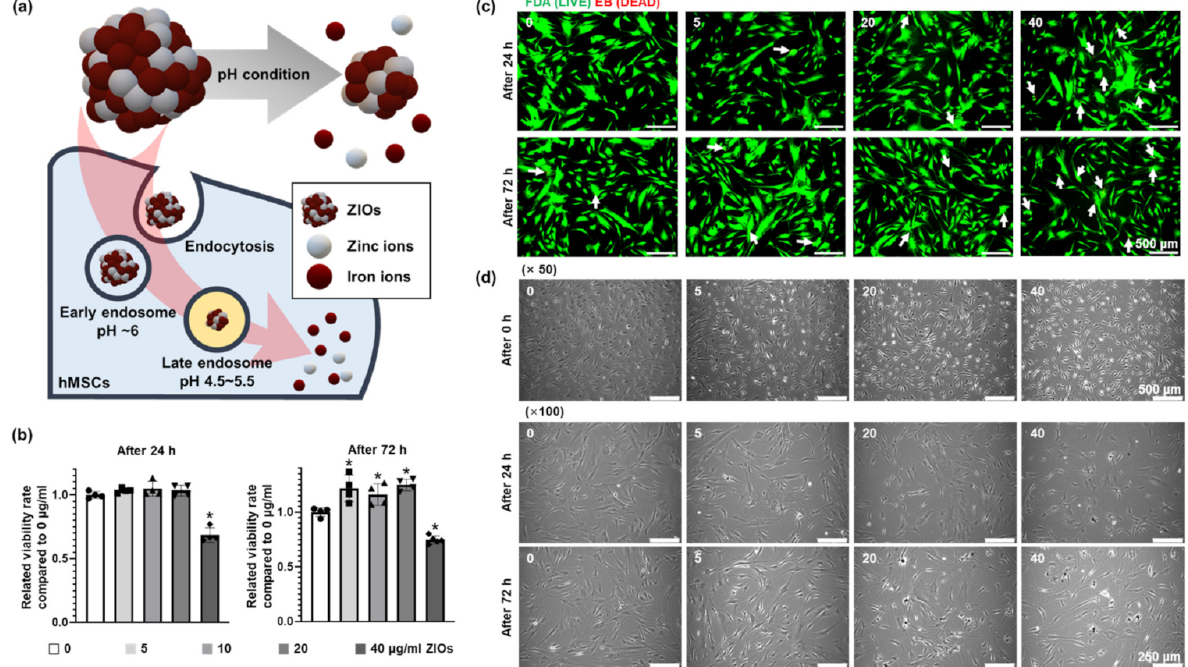
Figure 2. Cytotoxicity of ZIOs on human mesenchymal stem cells (hMSCs) according to ZIOs concentration and treating time. ( a ) Schematic diagram depicting the endocytosis of the ZIOs to hMSCs. To determine the cytotoxicity of the ZIOs on hMSCs, ( b ) relative cell viability ratio was evaluated by neutral red assay using the 0 µ g/mL group (normal cells) as a control (* p < 0.05, compared to the control group). ( c ) Apoptotic activity of hMSCs after ZIOs treatment as evaluated by the fluorescein diacetate ethidium bromide (FDA-EB) assay (live cells; green, dead cells; red). Dead cells were indicated with white arrows. (Scale bars: 500 µ m). ( d ) Representative cell morphology of hMSCs after ZIOs treatment (Scale bar: 500 µ m ( × 50) and 250 µ m ( ×